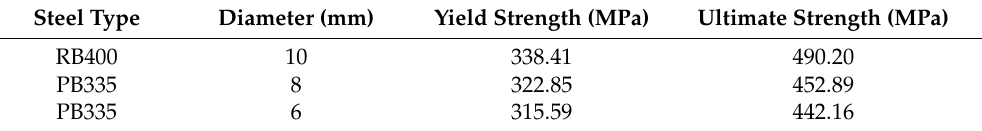
Table 3. Material properties of steel bars.